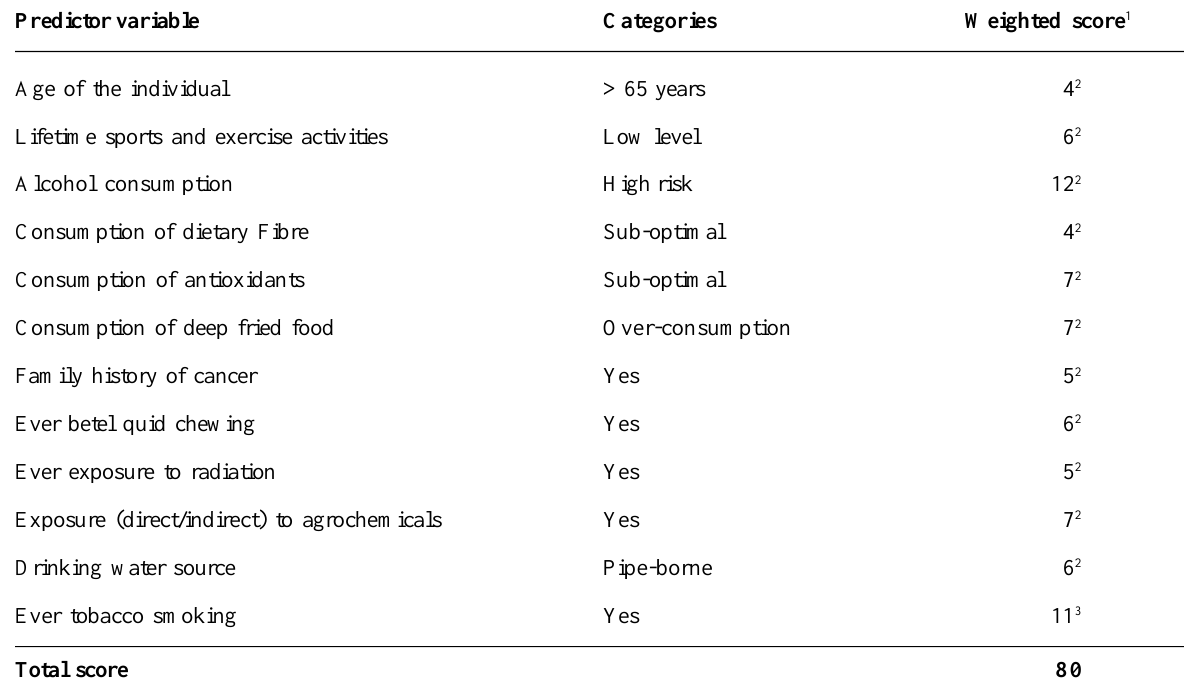
Table 2. Risk prediction model for assessing the risk of oesophageal